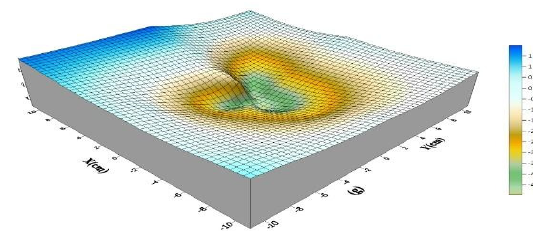
Fig. 7(g): The Scour and Deposition Pattern around Pier (P 1 ) at angle 12 0 and flowrate 9 L/Sec.